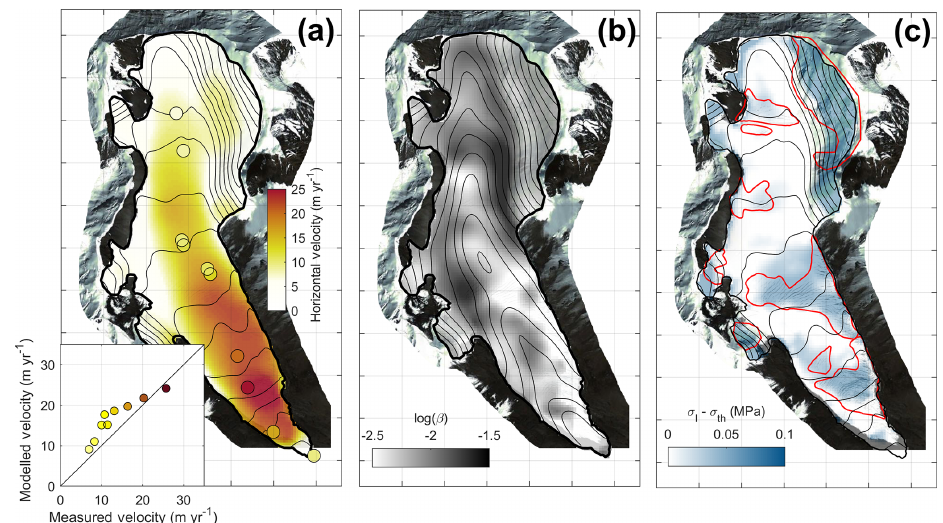
Figure 7. (a) Steady-state surface velocities compared with the measurements (coloured dots and inset). Contour lines are surface topography with 50m intervals (b) Friction coefficient inferred from emergence velocities (assumed to be opposite of surface mass balance). Contour lines are bedrock topography with 50m intervals. (c) Modelled crevassed areas from maximal Cauchy stress anomaly (colour scale) compared with observations (red lines).